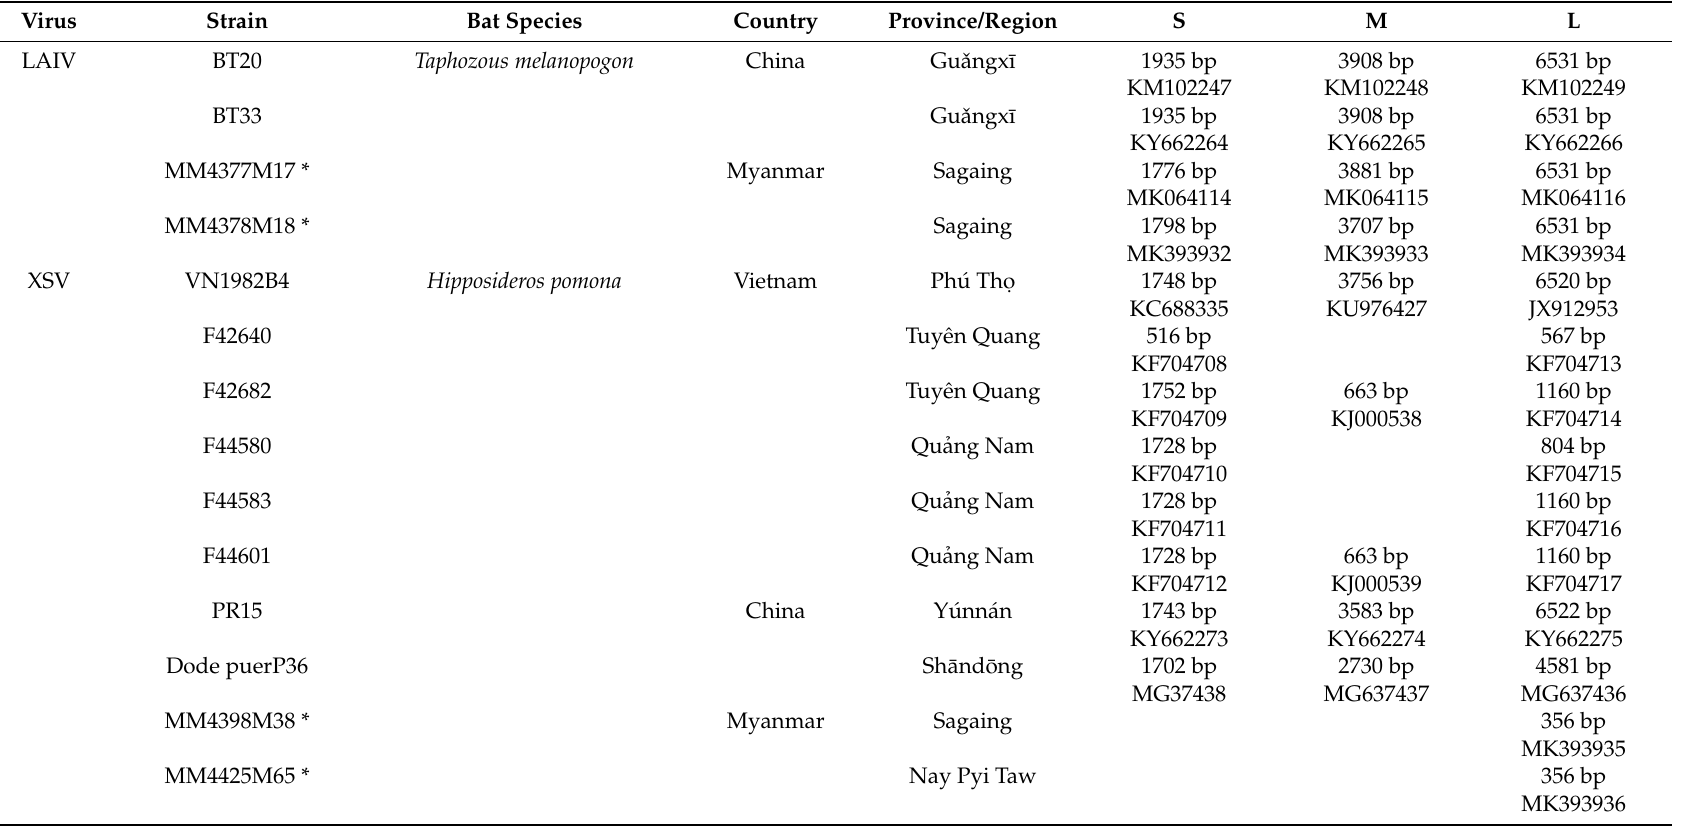
Table 3. L á ib¯ın virus (LAIV) and Xu â n S ơ n virus (XSV) in insectivorous bats in Myanmar and Vietnam. Virus